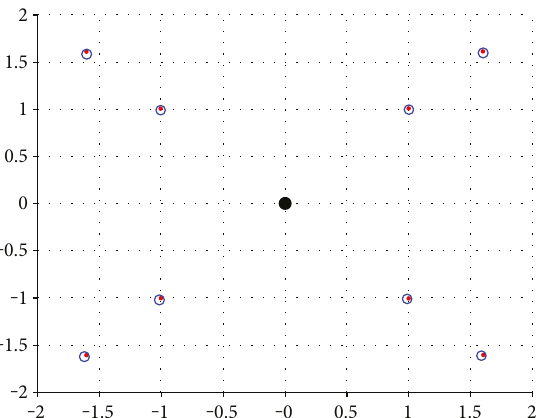
Figure 12: The normal detection algorithm tester: shown in blue are the real points of the orthogonal segment corners to the normal and shown in red is the algorithm